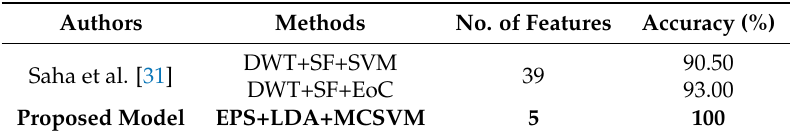
Table 5. Performance comparison of the proposed model with other state-of-the-art methods on the DU-MD dataset.